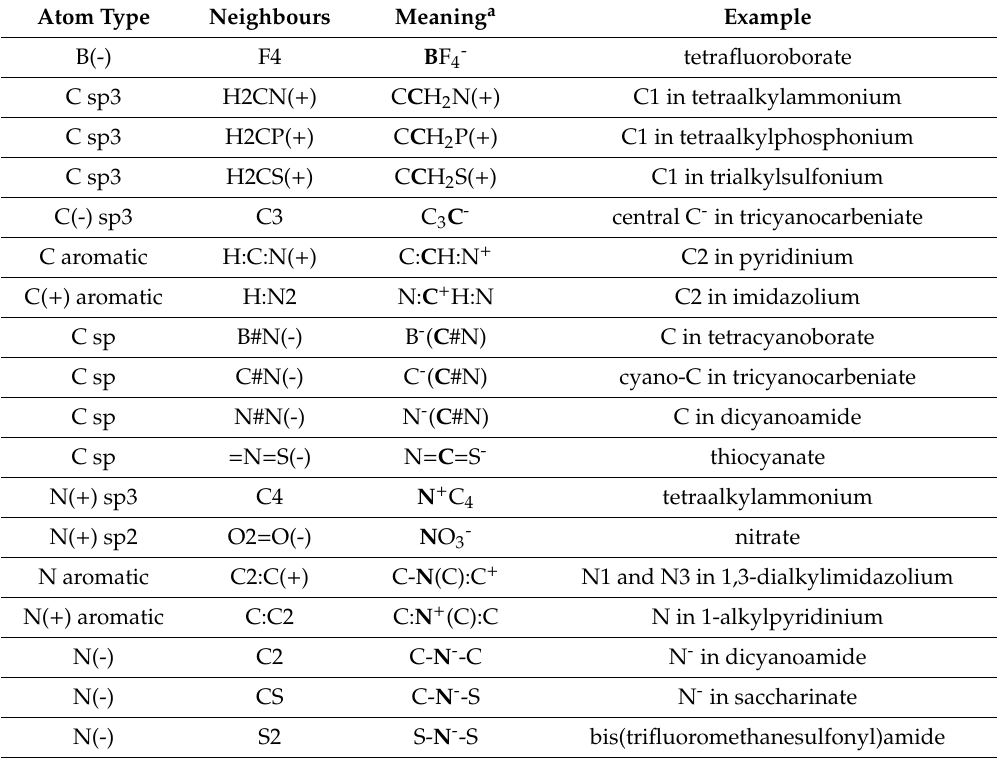
Table 1. Atom-group examples for ionic liquids and their